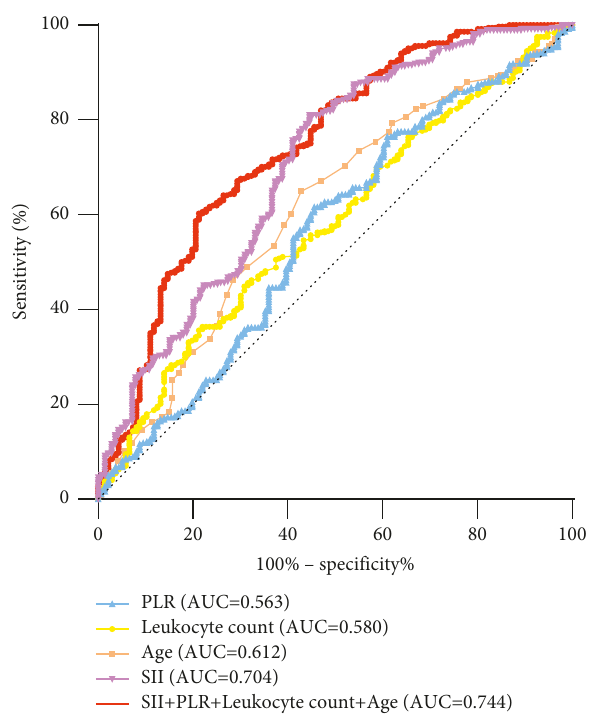
Figuer 1: ROC curve of each independent factors. Table 3: ROC curve analysis of each independent influencing factor.